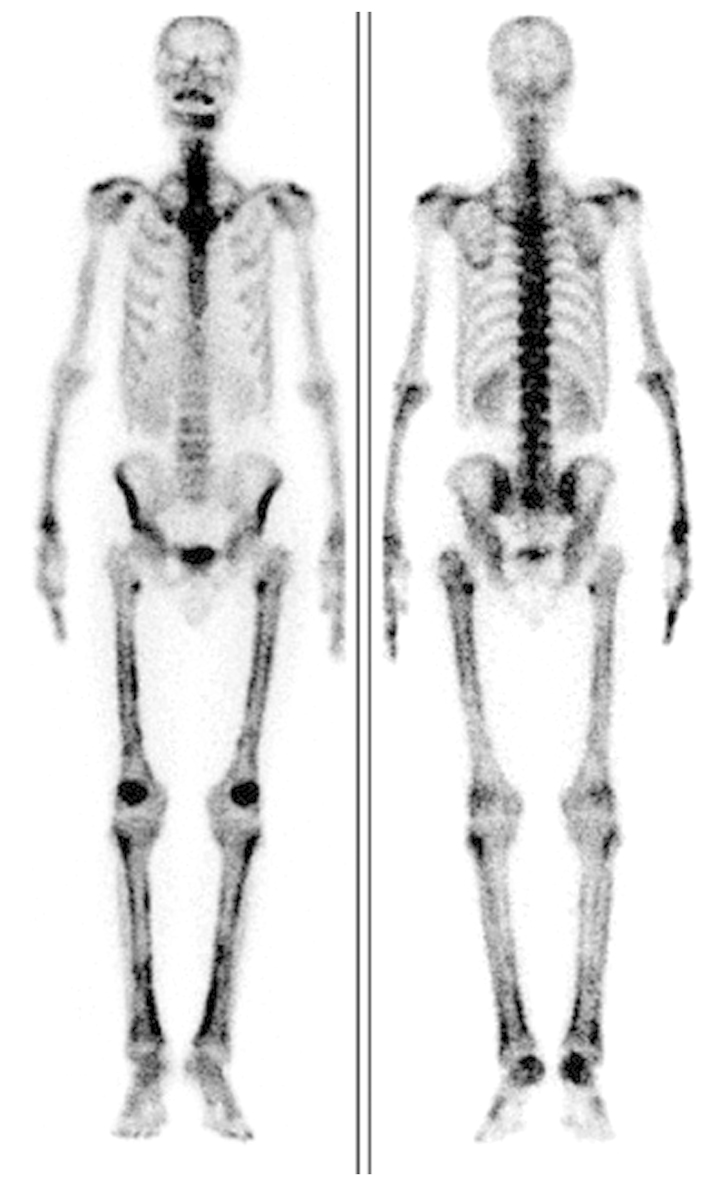
Bilateral femur uptake of 99mTc-hydroxymethylene diphosphonate on bone scintigraphy.